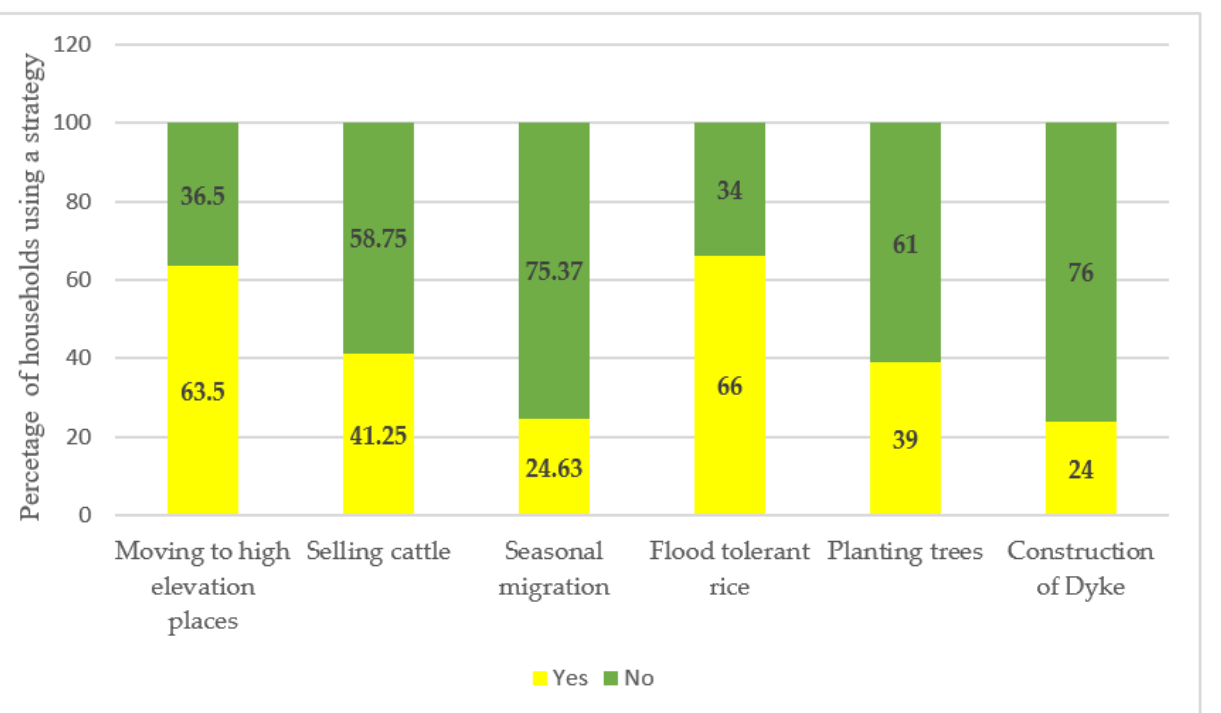
Table 4. Regression Results of the Socioeconomic Model (Short-term coping methods). Moving to High Elevation Places (B)